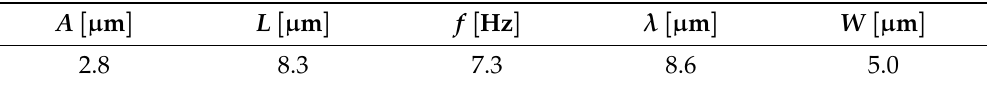
Table 1. Characteristic flagellum parameters specific to D. grandis . A is the wave amplitude, L is the projected length of the flagellum onto the center axis y , f is the wave frequency, λ is the wavelength, and W is the width of the flagellar